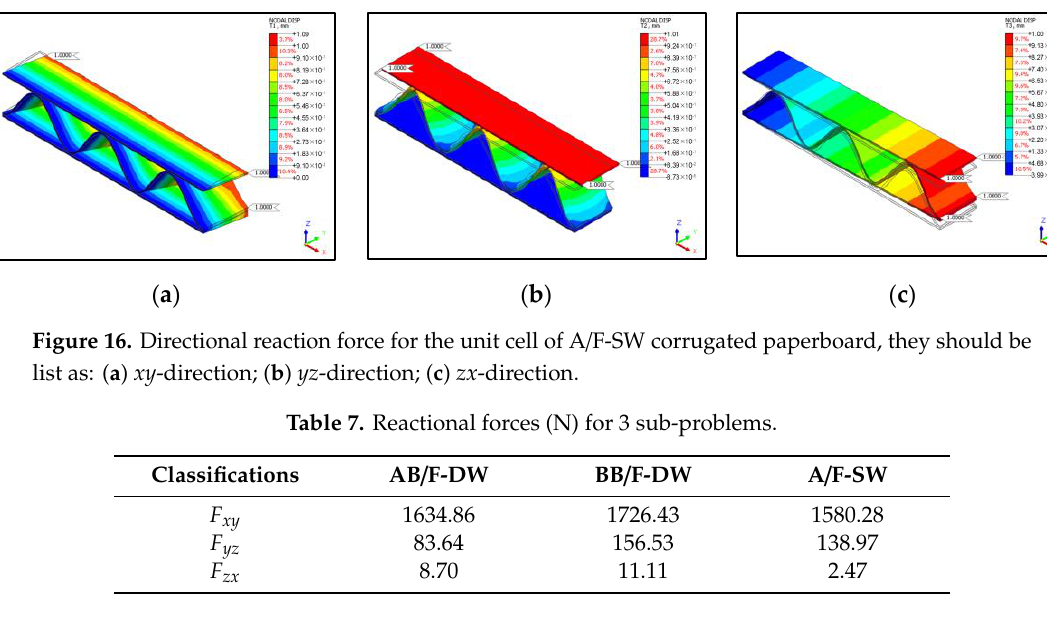
Table 8. Shear strain under simple shear in AB / F-DW corrugated paperboard.